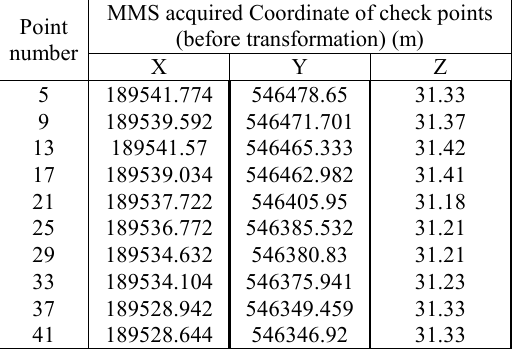
Table 4. Check point coordinates acquired by MMS